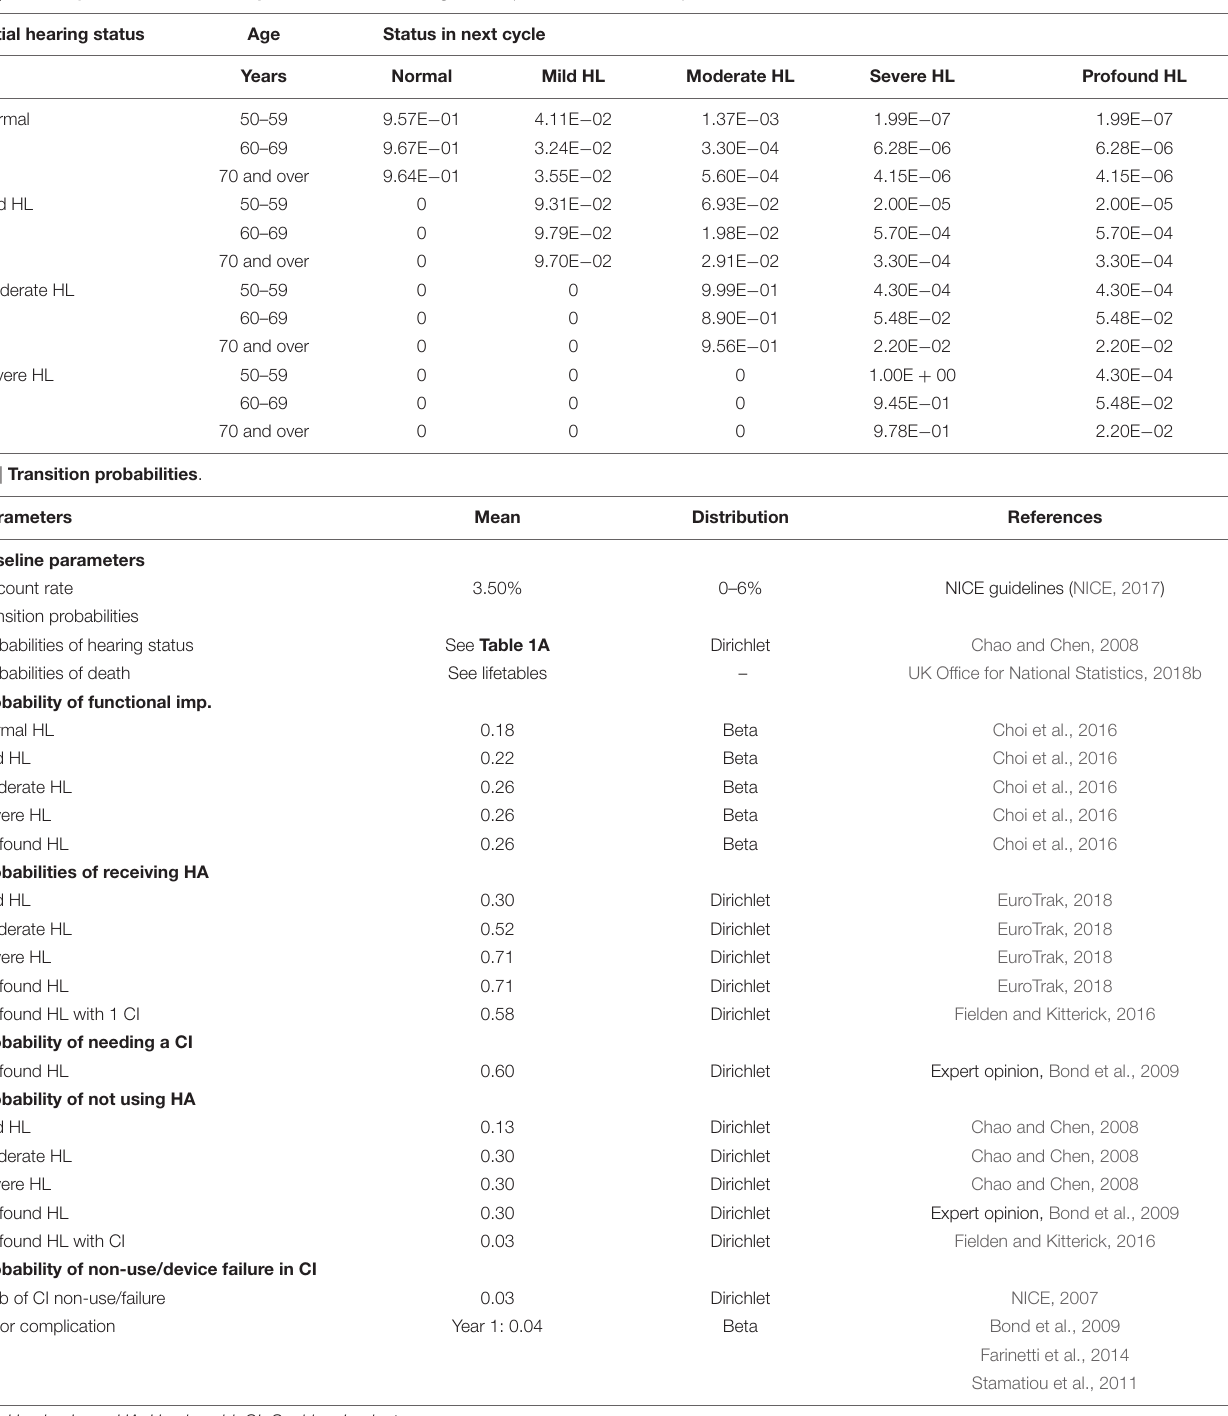
TABLE 1 | Transition